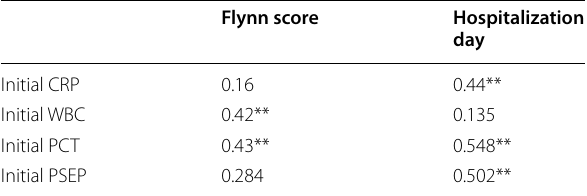
Table 7 AUC Findings